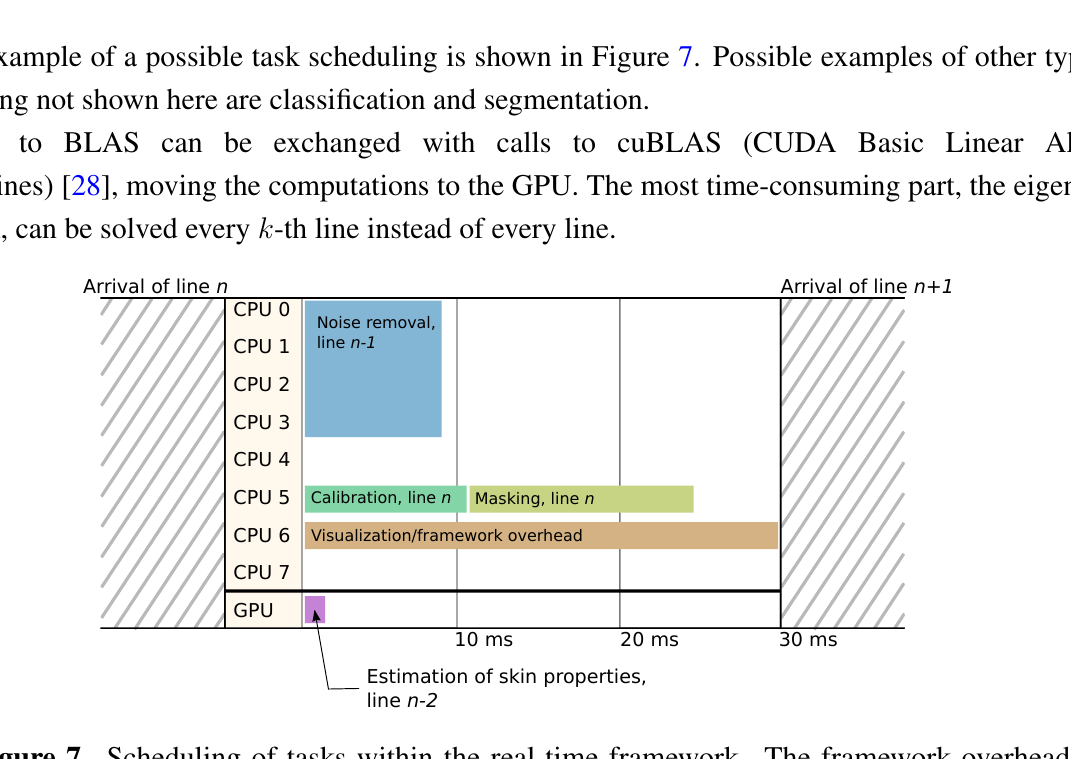
Figure 7. Scheduling of tasks within the real-time framework. The framework overhead time is an example and not an exact